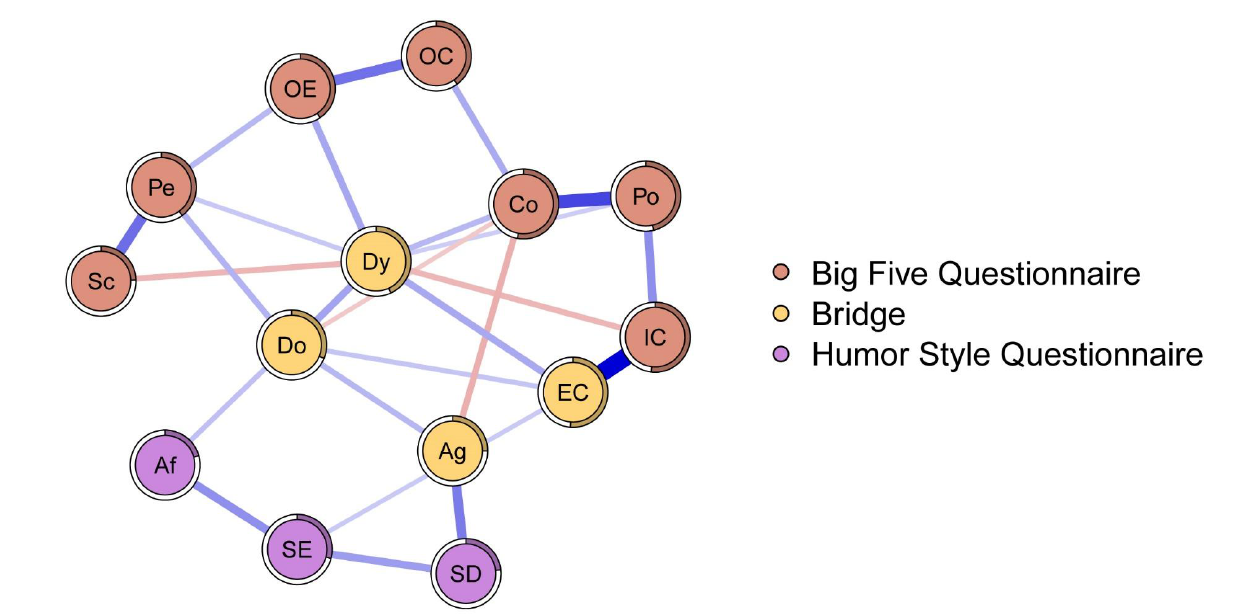
Figure 7. Network model of Humor Styles dimensions and Big Five Personality Facets: Graphical representation of the Bridge Nodes and Bridge Expected Influence (n = 462). Note: Big Five Ques- tionnaire (BFQ) ten facets. Dy: Dynamism; Do: Dominance; Co: Cooperativeness; Po: Politeness; Sc: Scrupulousness; Pe: Perseverance; EC: Emotion Control; IC: Impulse Control; OC: Openness to Culture; OE: Openness to Experiences. Humor Style Questionnaire (HSQ) four dimensions. Af: Affiliative; SE: Self-enhancing; Ag: Aggressive; SD: Self-defeating.